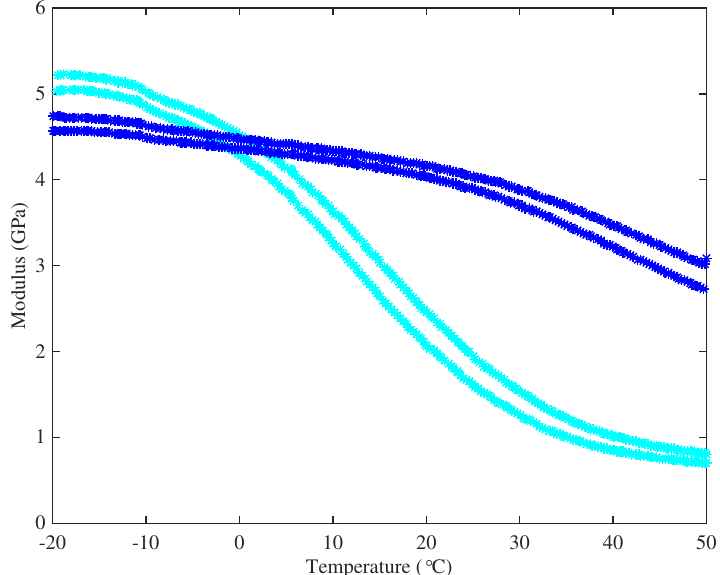
Figure 8. DMA measurements of the real part of Young’s modulus as a function of temperature, for samples of String 5 (A4, blue) and String 29 (E3, cyan). For each string, lines of stars denote measurements at 1 Hz (lower curve) and 10 Hz (upper curve). Tests were done in a clamped three-point bend configuration with zero axial stress.